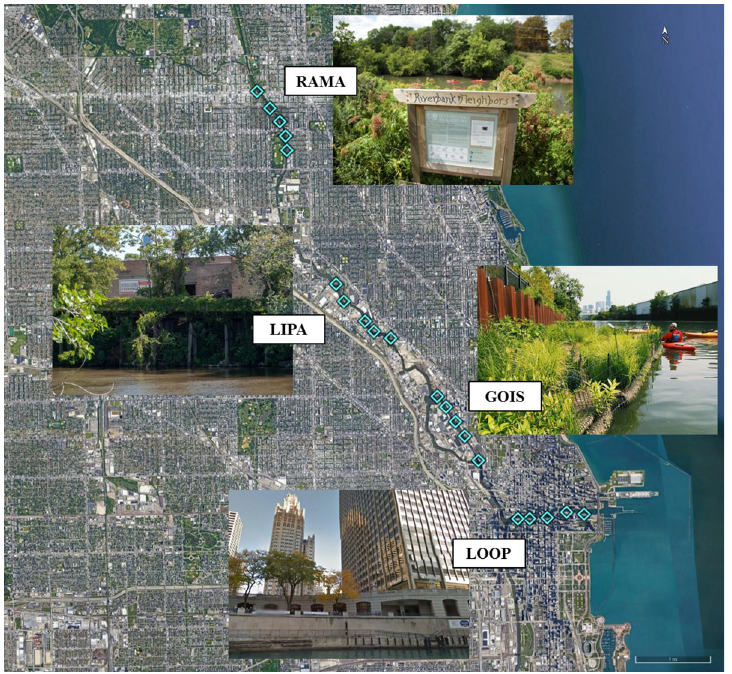
Fig 1. Overview of study sites. Aerial view of study points along the Chicago River, with characteristic imagery from each of the four study river sections. Aerial imagery is from Google Earth Pro (imagery date 5/4/2019). Inset images are from (from top to bottom) Riverbank Neighbors Park, Joy Elaine Davenport, Urban Rivers, and Google Earth StreetView.